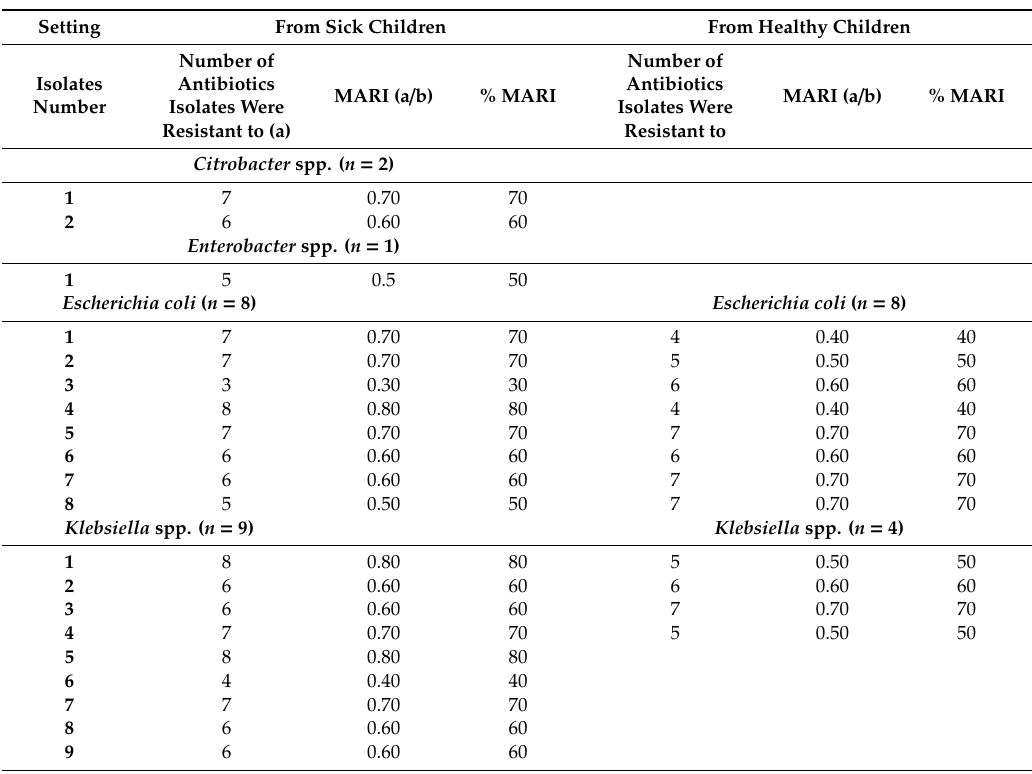
Table 6. Overall multi-antibiotic resistance index (MARI) of all the ESBL-producing Enterobacteriaceae (ESBL-PE)